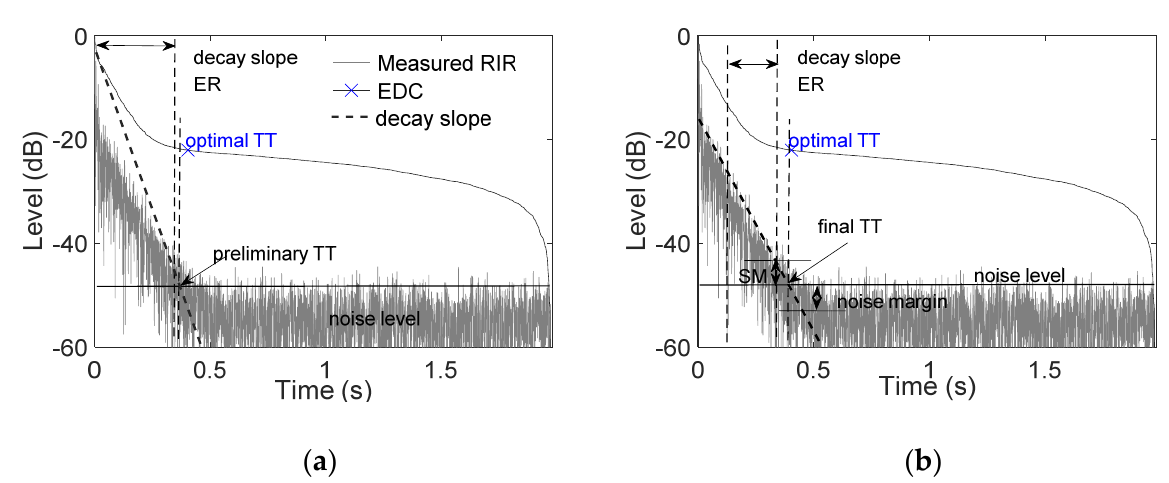
Figure 1. Detection of TT dependent on the ER: ( a ) the preliminary TT generated from the estimated ER; ( b ) the final TT generates from the ER with a selection slope margin and noise margin.